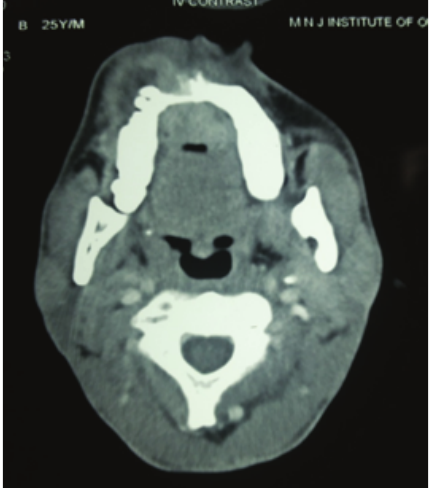
Figure 6: Axial CT scan showing ill-defined enhancing soft tissue mass on anterior hard palate extending posteriorly up to the soft palate on right